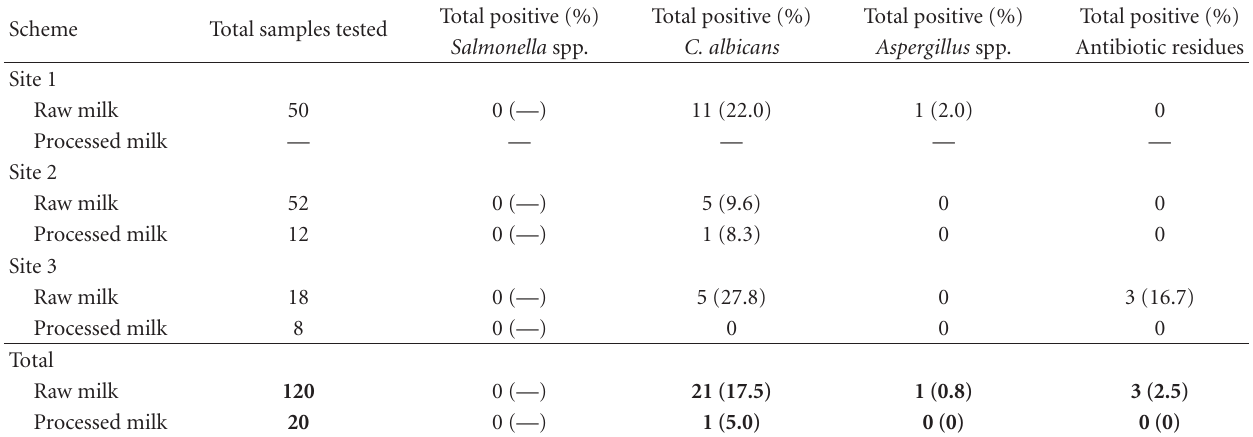
Table 1: Details of the total numbers and positive milk samples for Salmonella spp., Candida albicans , Aspergillus spp., and antimicrobial residues from selected smallholder dairy farms from sites 1, 2, and 3 of Zimbabwe.